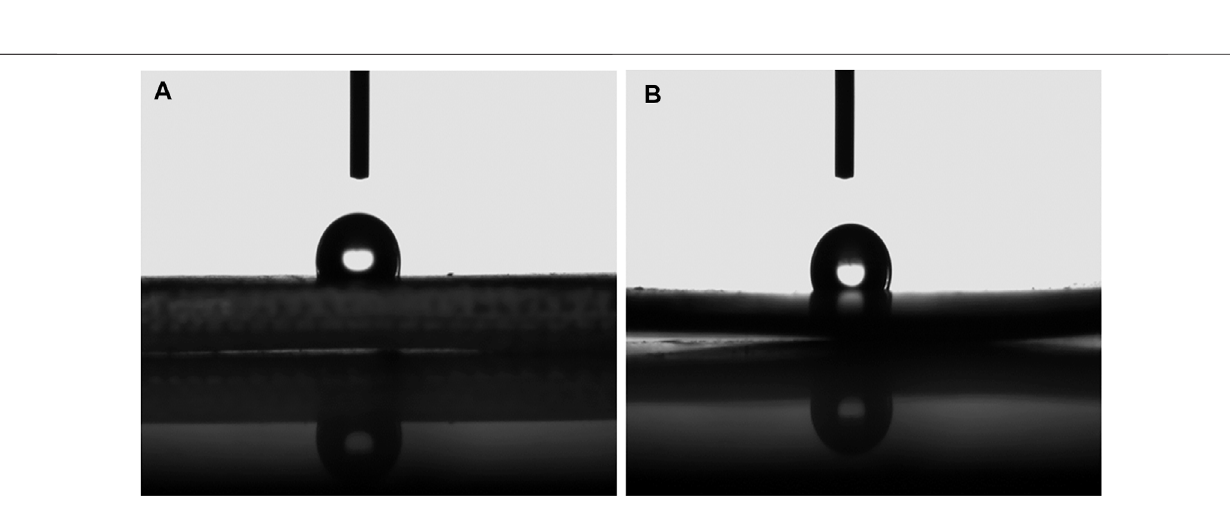
Frontiers in Bioengineering and Biotechnology |